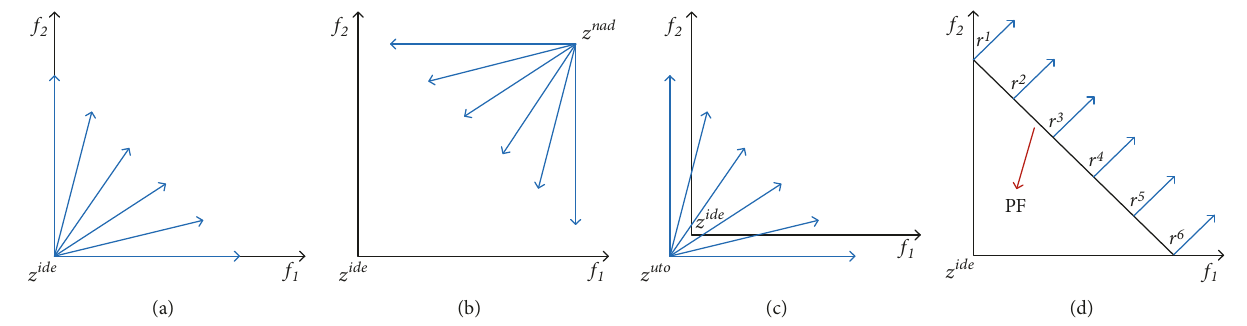
Figure 2: Four different cases of reference points in decomposition functions: (a) the ideal point; (b) the nadir point; (c) the utopian point; (d) multiple reference